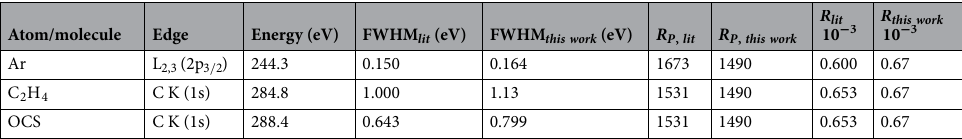
Energy and the FWHM